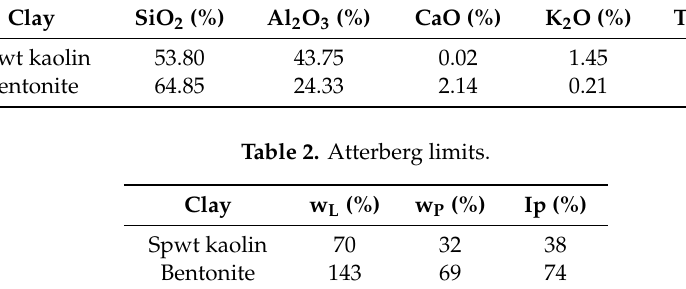
Figure 1. X-ray diffraction patterns: ( a ) Spwt kaolin; ( b ) Bentonite. Table 1. Chemical composition of clays.